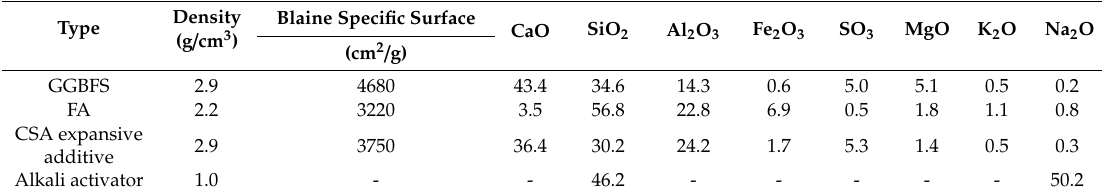
Table 1. Physical properties and chemical composition of alkali-activated material (AAM) binder and calcium sulfoalumiante expansive additive (CSA